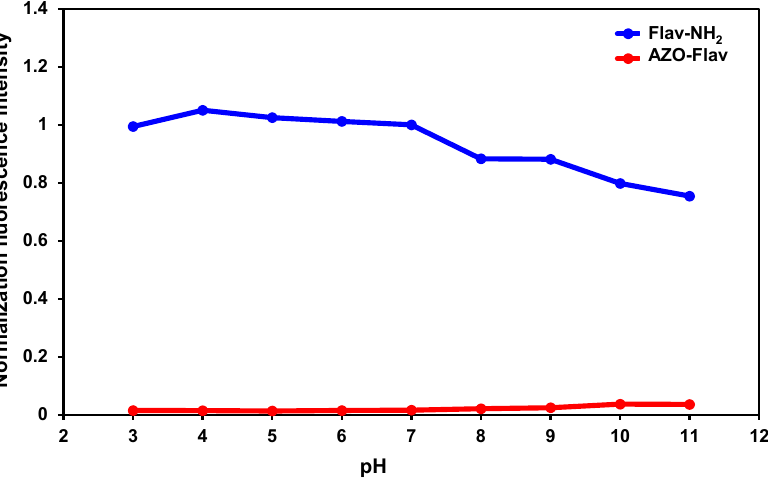
Figure 2. Fluorescent response of AZO-Flav and Flav-NH 2 (10 μ M) at different pH values ( λ ex = 540 nm and λ em = 607 nm).